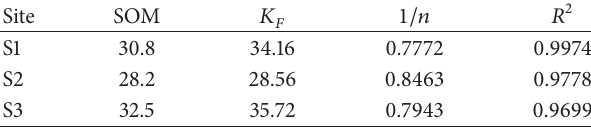
Table 1: Fitting parameters of Freundlich